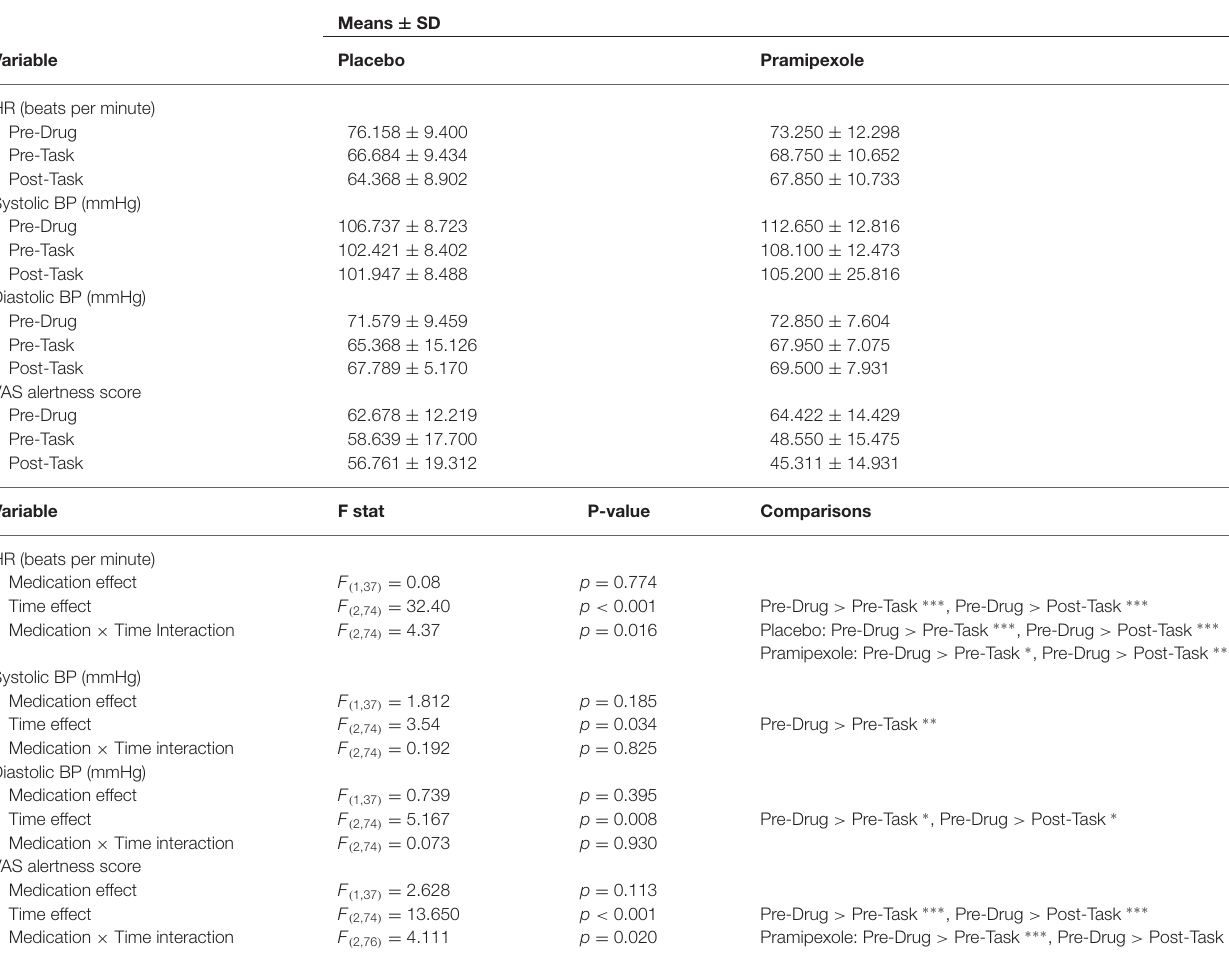
TABLE 2 | Physiological measures for healthy participants treated with either standard placebo or 0.5 mg pramipexole. Means ±